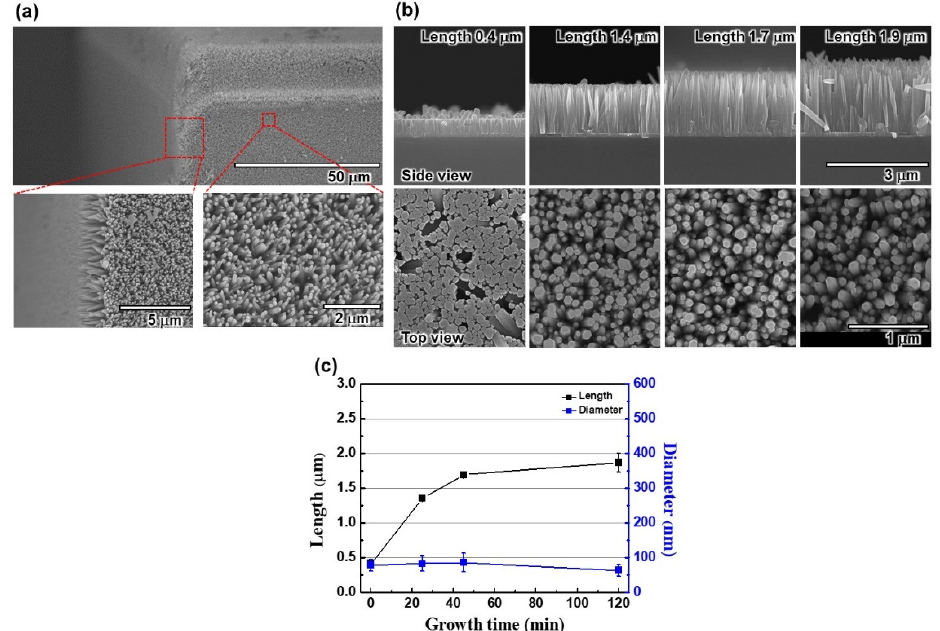
Figure 3. ( a ) SEM characteristics of fabricated ZnO nanorods on the sidewalls of a USE-LED. ( b ) SEM characteristics of various ZnO nanorods’ lengths and diameters for side and top views, respectively. ( c ) Variation of ZnO nanorods’ lengths with the growth times.